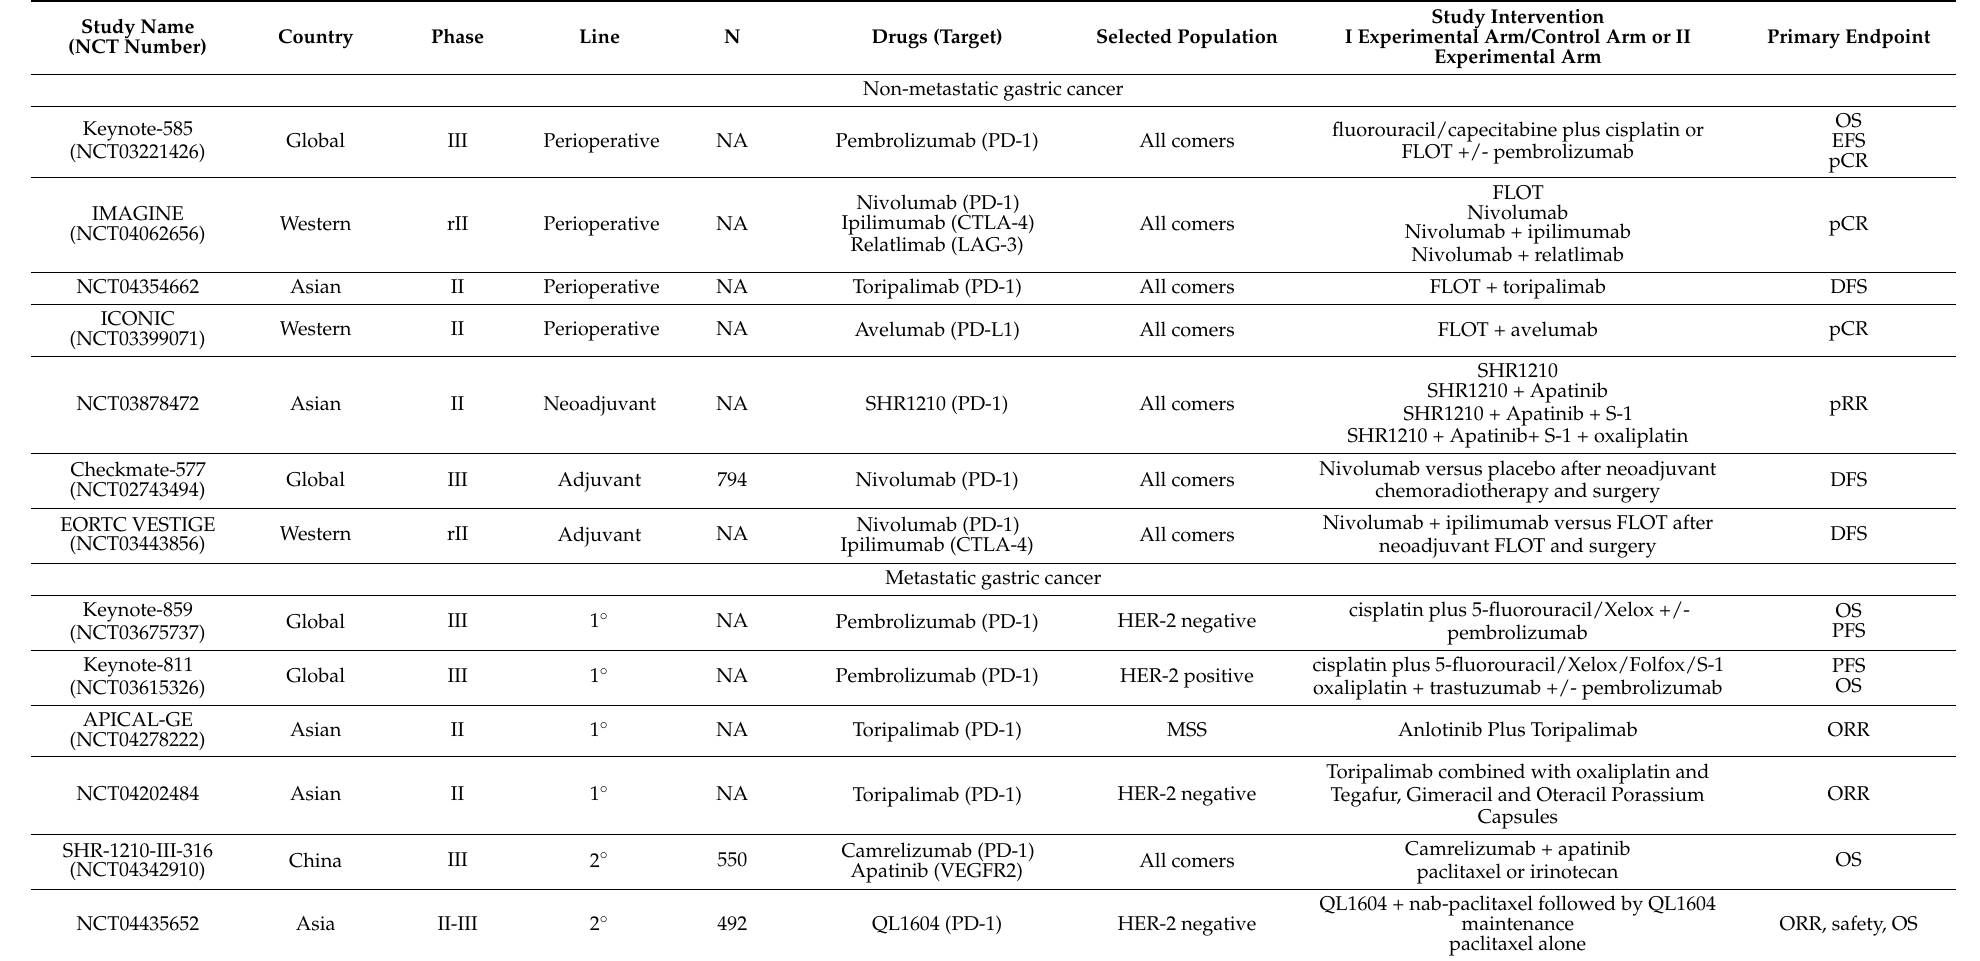
Table 2. List of major ongoing phase I-III trials with immune checkpoint inhibitors in gastric